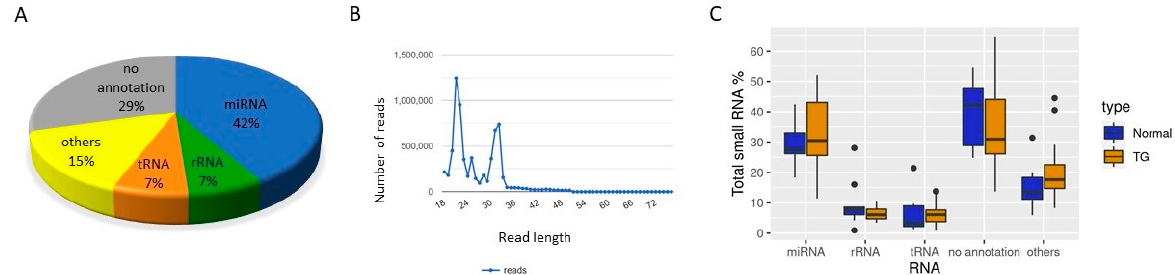
Figure 1. Serum small RNA composition in TG and normal allograft patients. ( A ) Distribution of reads in a representative small RNA library (TG-143). ( B ) Read length distribution of a representative sRNA library. Distinct peaks indicate the protection and cloning of RNA fragments. ( C ) Distribution of different small RNA categories in TG and control patients.